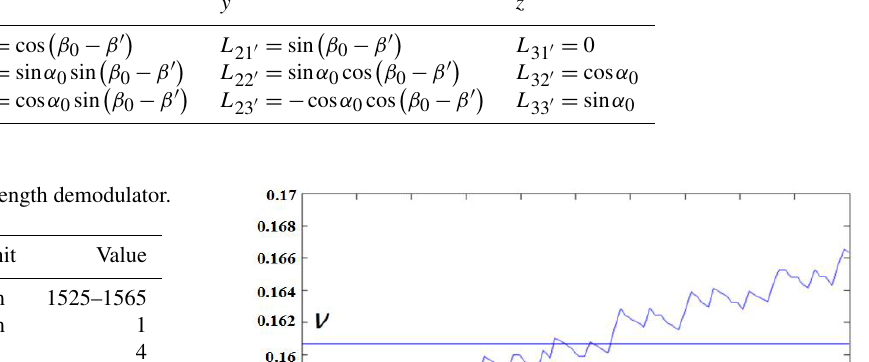
Table 2. Direction cosine of the local coordinate system O- x (cid:48) y (cid:48) z (cid:48) relative to the global coordinate system O- xyz . Coordinate